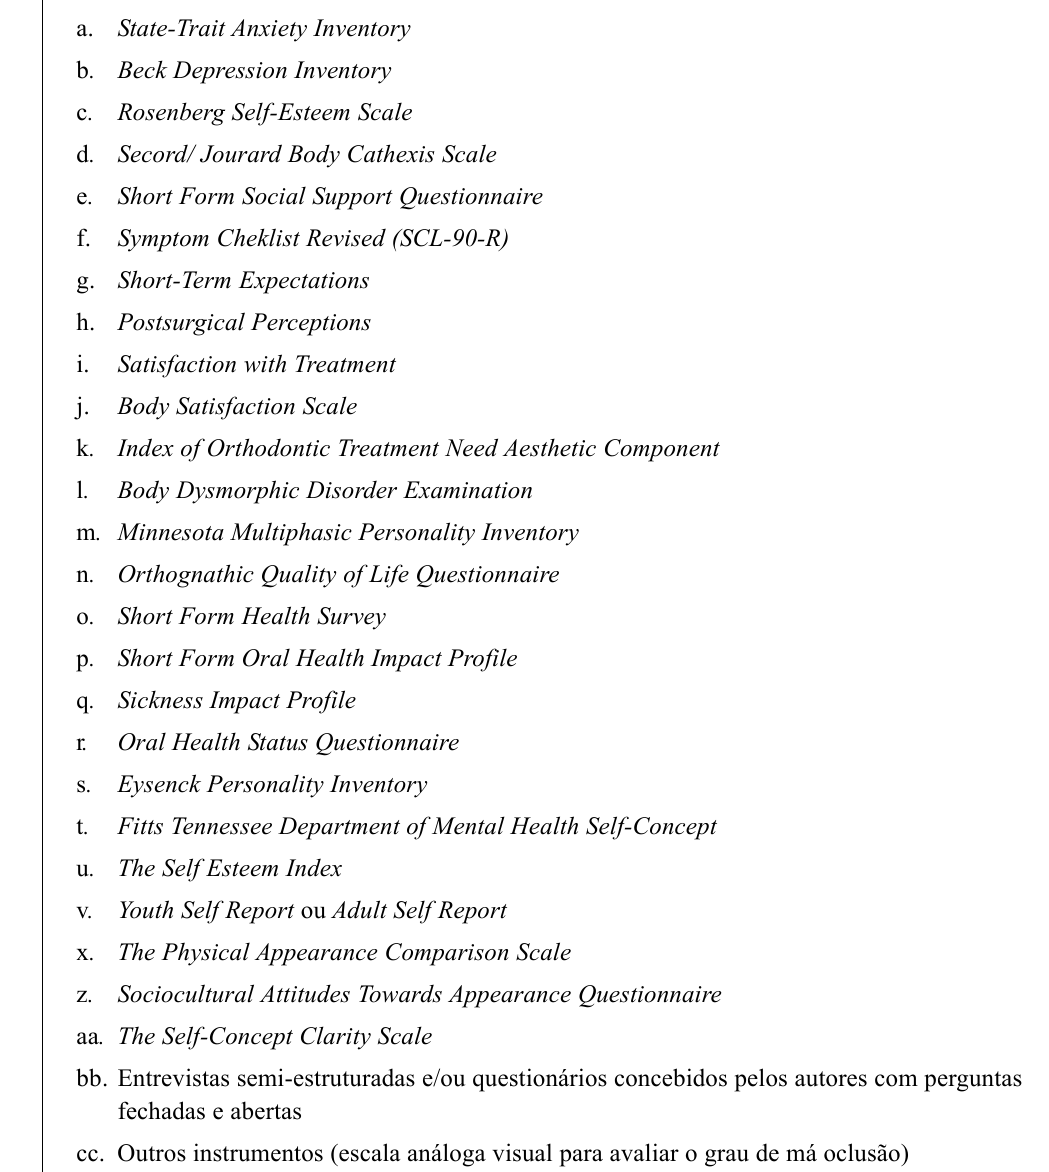
Figura 1 . Identificação de questionários usados nos estudos da presente revisão.